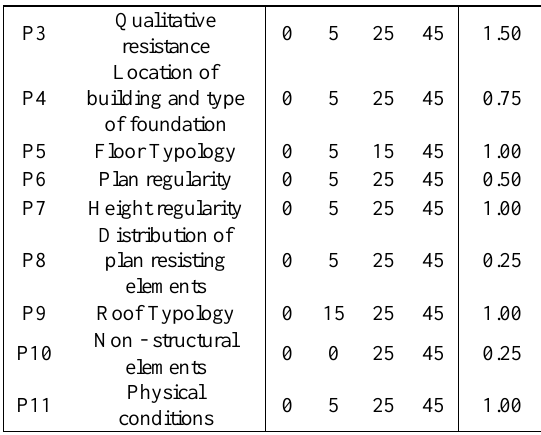
Table 3. Structure of the GDNT II Method.